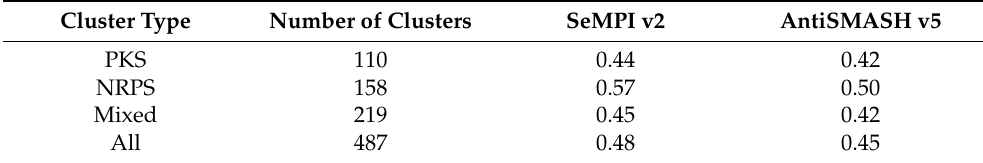
Table 9. Average (arithmetic mean) Tanimoto similarity between produced SMs and the predictions made by SeMPI v2 and antiSMASH v5.